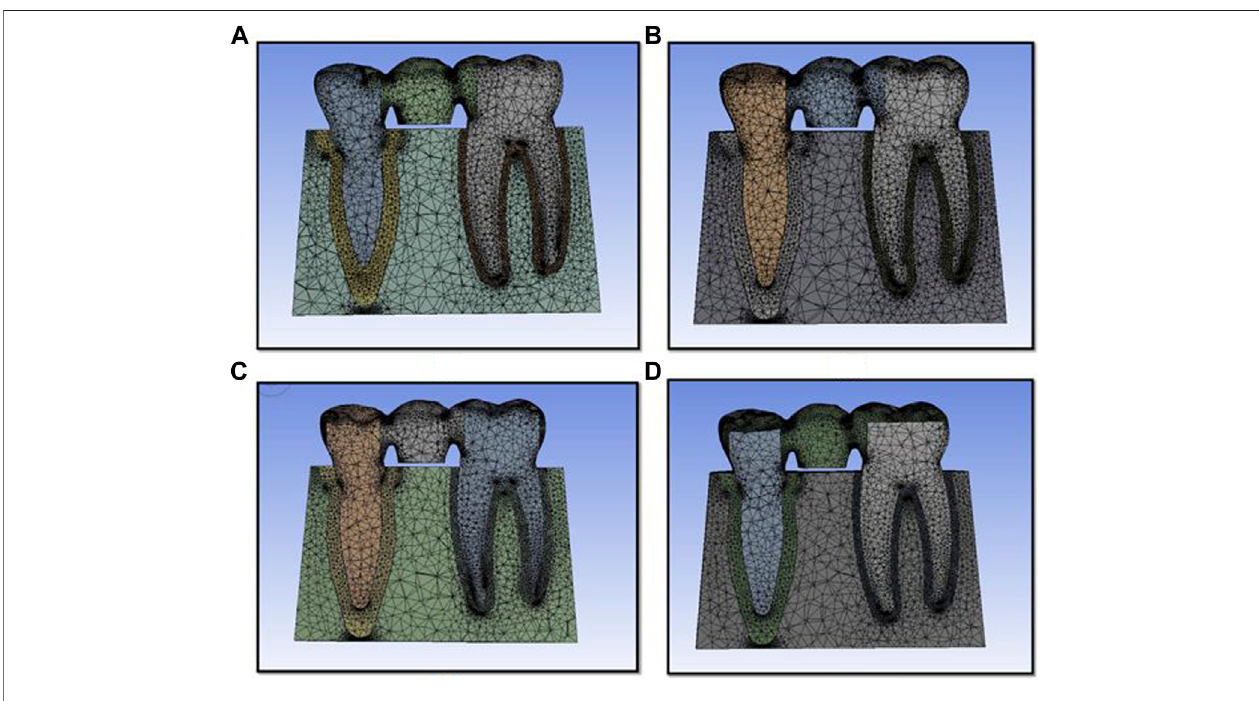
FIGURE 2 | Finite element model used for the study for design 1 (A) , design 2 (B) , design 3 (C) , and design 4 (D) .